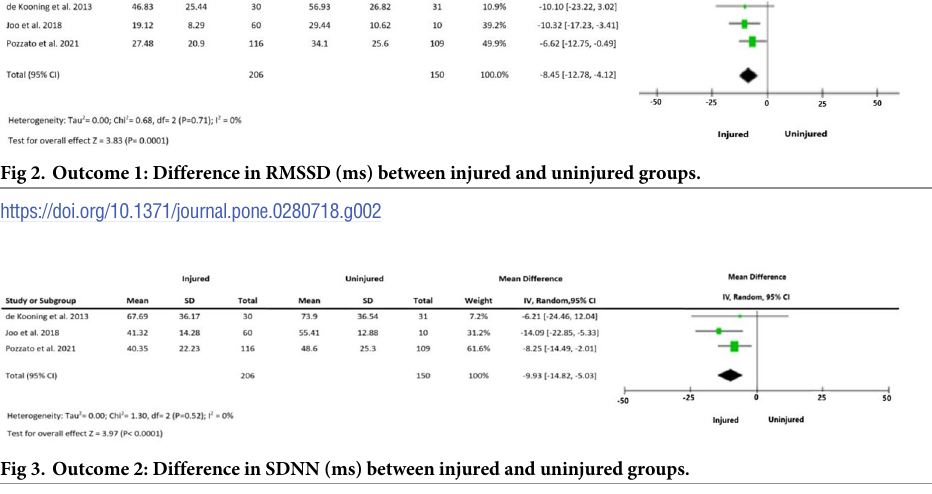
Note: Direction of means represented as ( " high, # low) for the exposed group compared with the mean of the control group from each study.